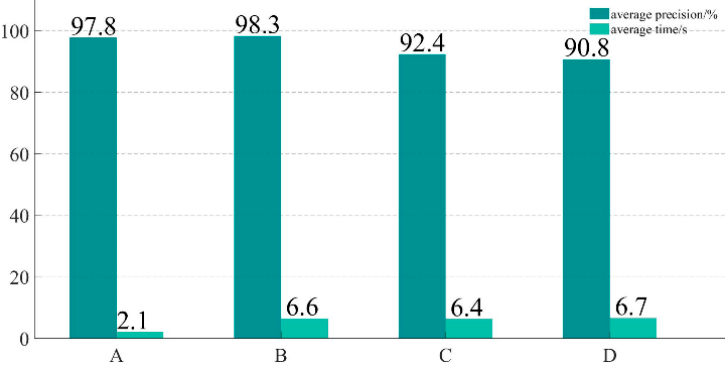
Figure 16. Comparing results between different models. A: The method proposed in this paper. B: Xception. C: Resnet-50. D: DenseNet-121. Table 8. Comparison between Different Methods.